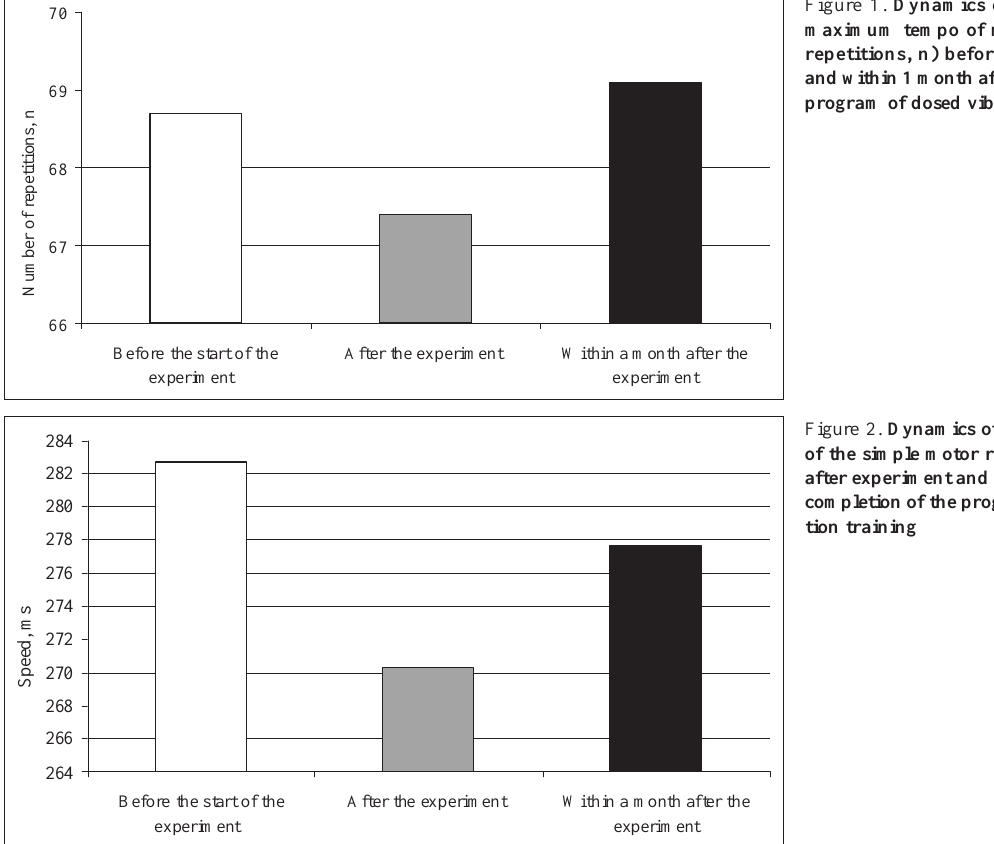
Figure 1. Dynamics of indicators of the maximum tempo of motions (number of repetitions, n) before, after experiment and within 1 month after completion of the program of dosed vibration training